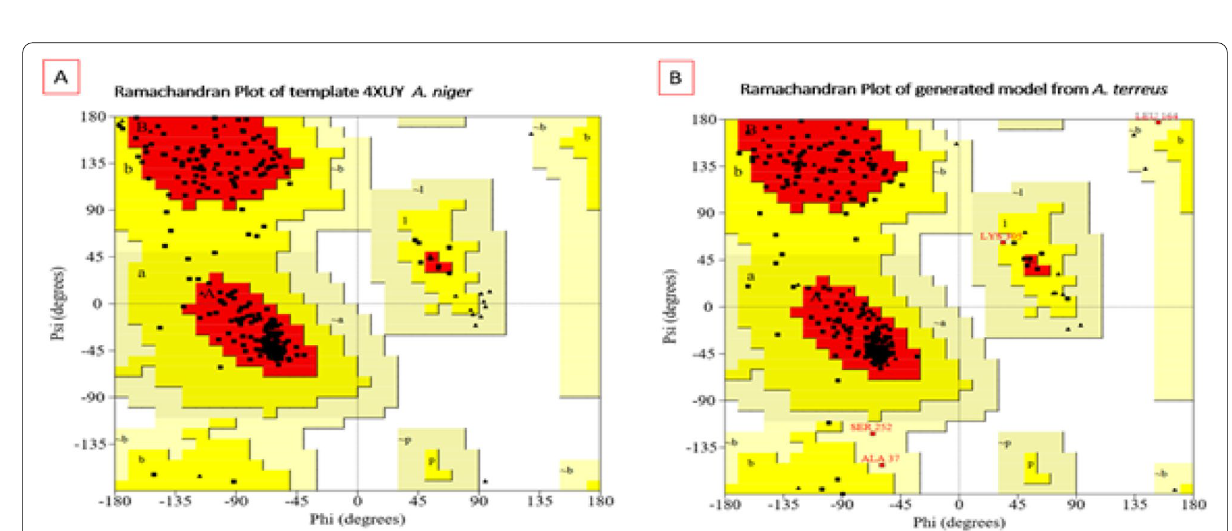
Fig. 23 Ramachandran plot for template Aspergillus niger (PDB 4XUY _A). a Modeled xylanase protein. b Obtained